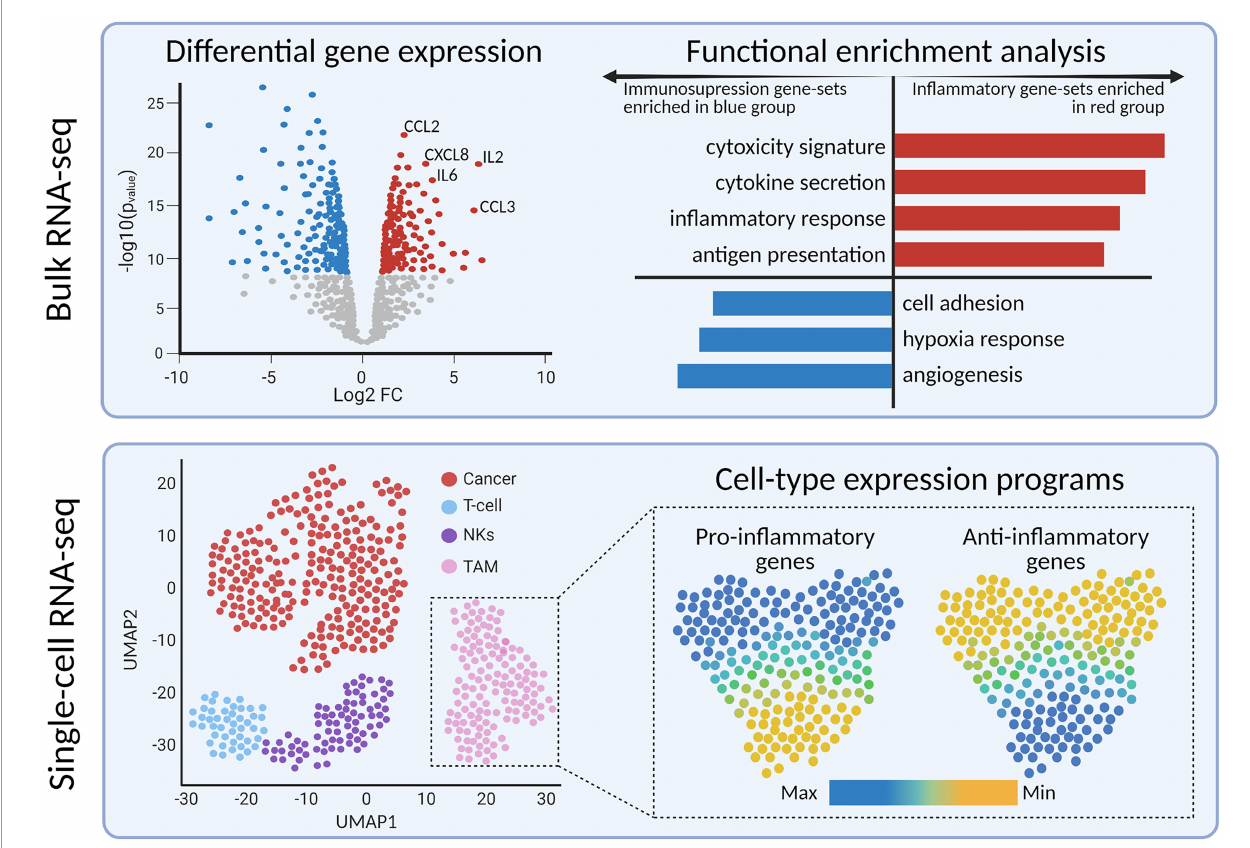
FIGURE 3 | Bulk and single-cell transcriptomics reveals differentially expressed genes and pathways between tumor sub-types or cell sub-populations,